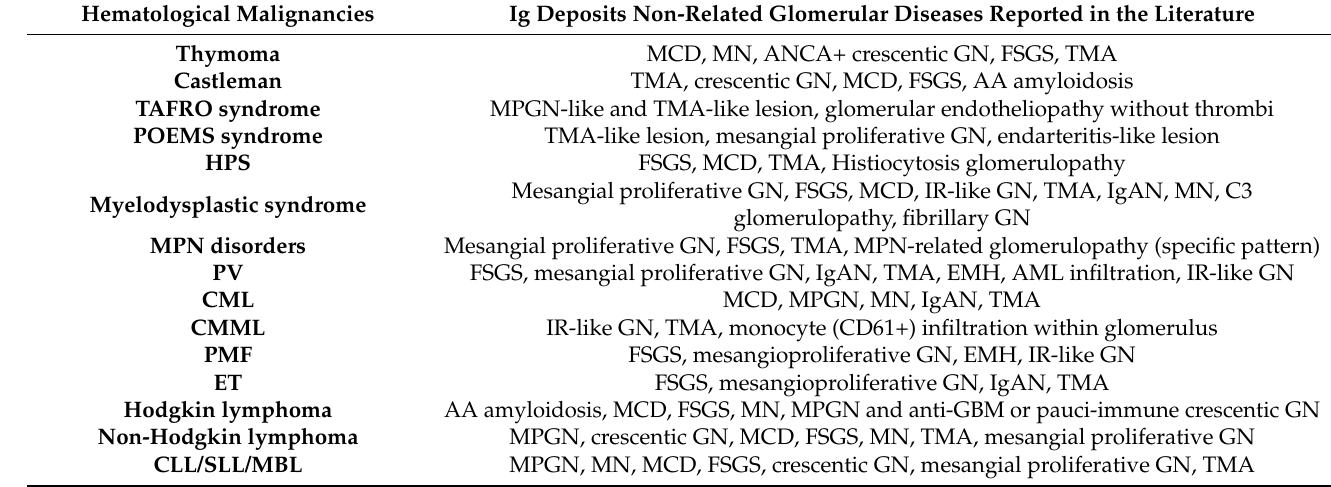
Table 1. Ig deposits non-related glomerular diseases associated with hematologic malignancies reported in the literature. Hematological Malignancies Ig Deposits Non-Related Glomerular Diseases Reported in the Literature Thymoma MCD, MN, ANCA+ crescentic GN, FSGS, TMA